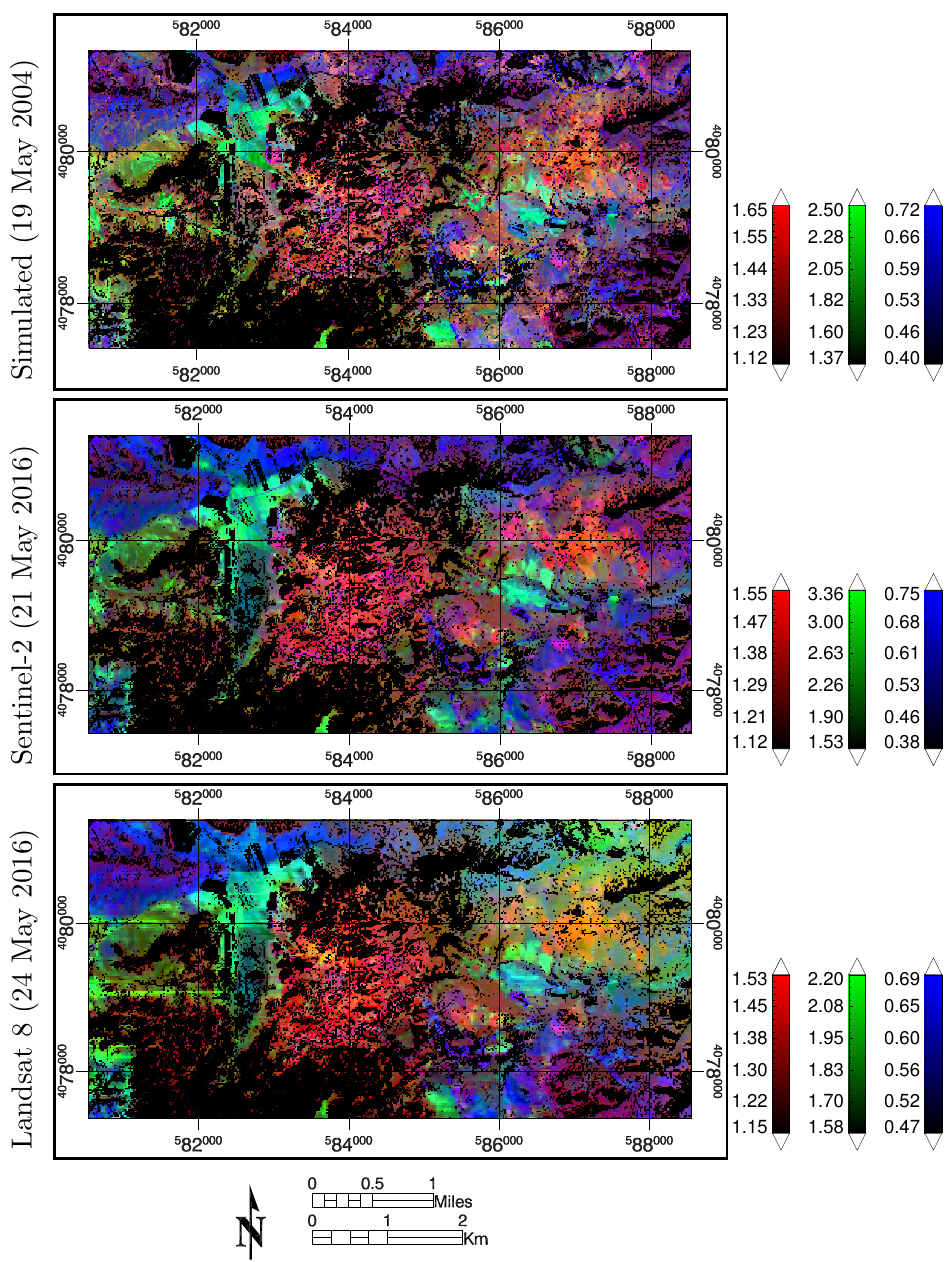
Figure 6. Sabins’ band ratio colour composites of a simulated Sentinel-2A MSI data cube ( top ), Sentinel-2A MSI ( centre ) and Landsat 8 OLI ( bottom ). Shown are ratios TM 5/7 (ShortWave InfraRed 1/ShortWave InfraRed 2) in red, TM 3/1 (Red/Blue) in green and TM 3/5 (Red/ShortWave InfraRed 1) in blue. The patterns appear similar to the human eye, but differences can be observed in the ratio TM 3/1 between the simulated dataset of 2004 and the Landsat 8 OLI and Sentinel-2A MSI datasets of 2016. The colour ramps show that data ranges